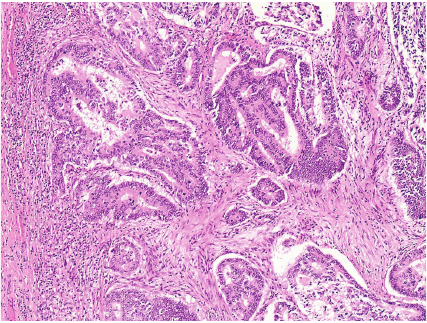
Figure 1: Adenocarcinoma of the colon, 100x